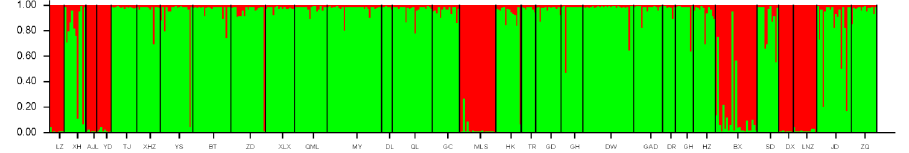
Figure 1. Results of grouping in Lancea tibetica by STRUCTURE.